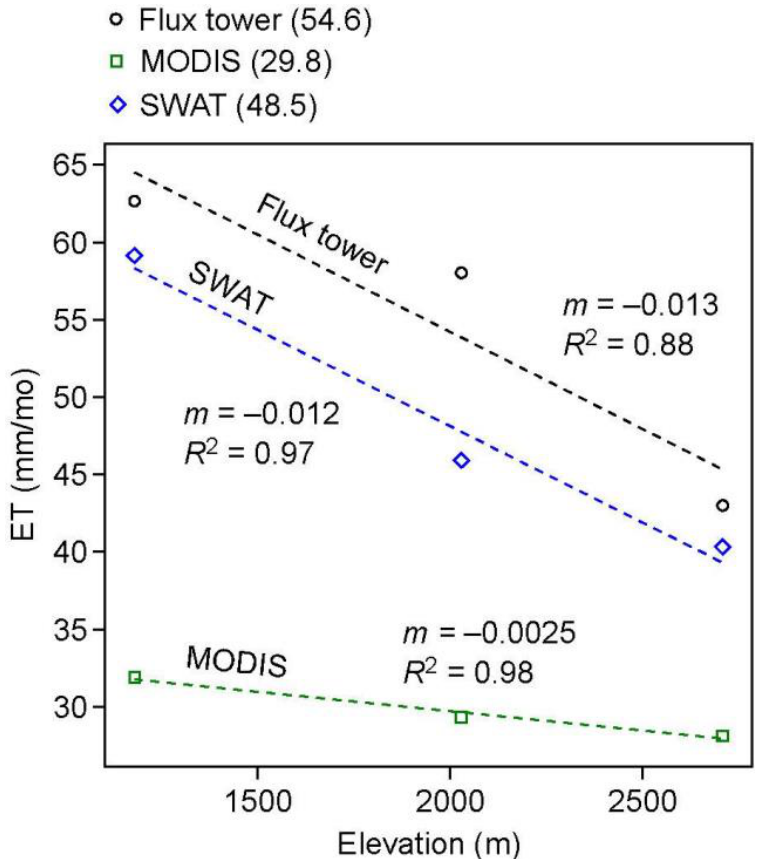
Figure 3. Average monthly ET versus elevation from flux towers, MODIS, and SWAT. Averages across all elevations are parenthesized in the legend. m = slope of linear-regression trendline, R 2 = coefficient of determination of linear-regression fit. In terms of the NSE metric of model fitness, the SWAT model matched monthly ET observations better than the MODIS model. The NSE of SWAT across all flux tower sites was +0.36, ranging from +0.04 at the middle site to +0.68 at the upper site (Table 2). In comparison, the NSE of MODIS across all sites was − 0.43, ranging from − 0.73 at the middle site to − 0.33 at the lower site. These negative NSE-values indicate a level of prediction efficiency lower than that provided by knowledge of long-term observed ET. Both SWAT and MODIS showed minimum prediction efficiency at the middle site (Table 2). In addition, both models showed slightly lower prediction efficiency (NSE lower by ~0.2) during wet years than dry years (Table